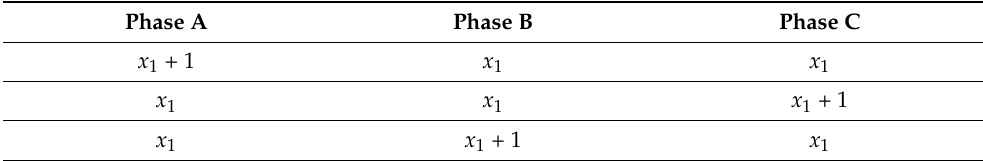
Table 3. Slot distribution to phases of UBW type A .